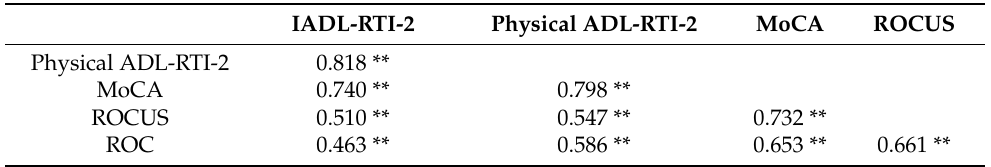
Table 4. Spearman correlation between ADL and categorization